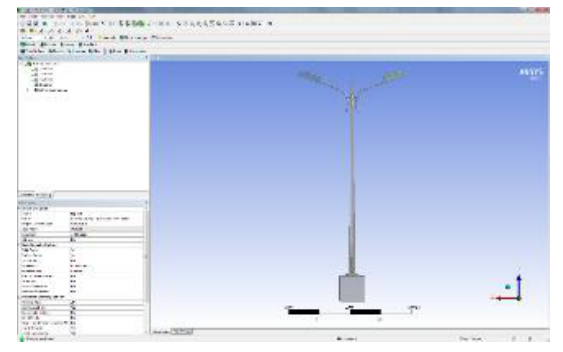
Fig. 2. The cad diagram for Street light